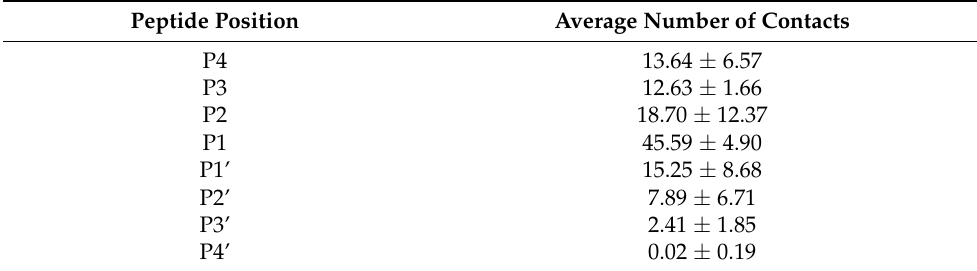
Table 2. Average and standard deviation of the number of non-bonded contacts between each position of the 8-mer peptide and the protein. The positions are named according to the standard nomenclature defined for proteases binding sites